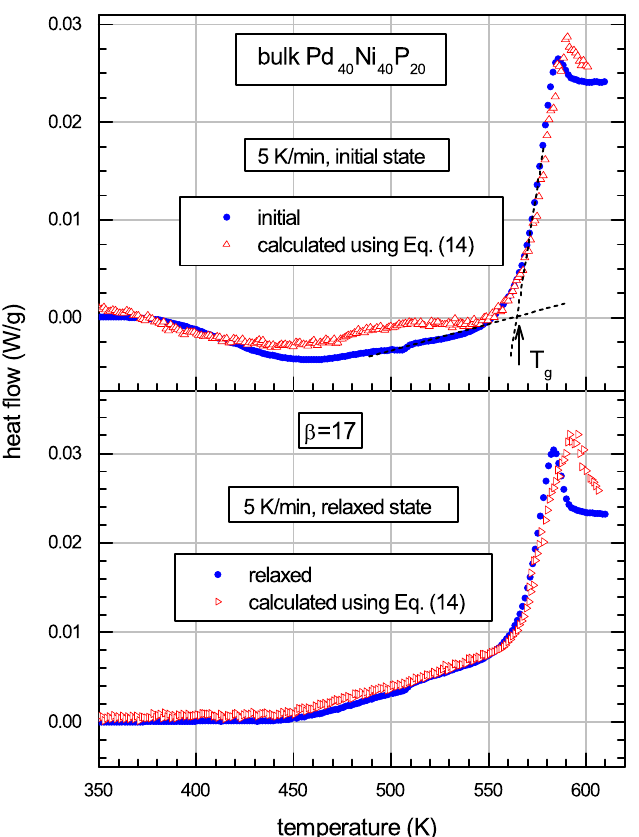
Ni P in 40 40 20